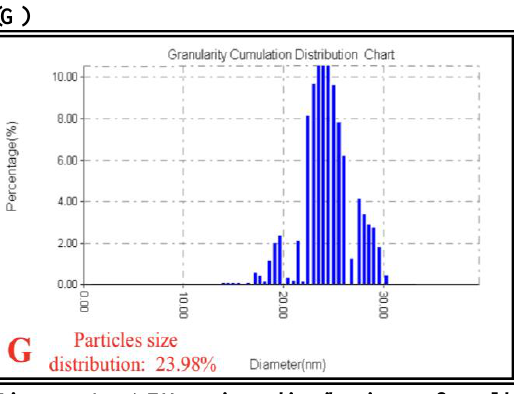
Figure 3. AFM 3D image of gold nanoparticles (G)